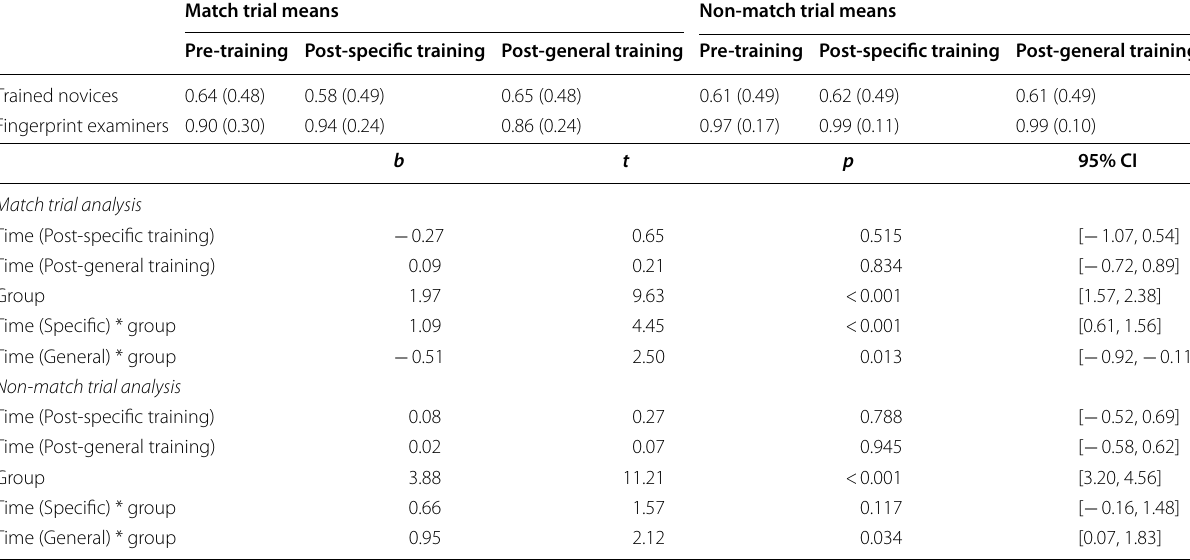
Table 3 Means, standard deviations (in brackets) and analyses on match and non-match trials pre-training and post-training between groups in Experiment